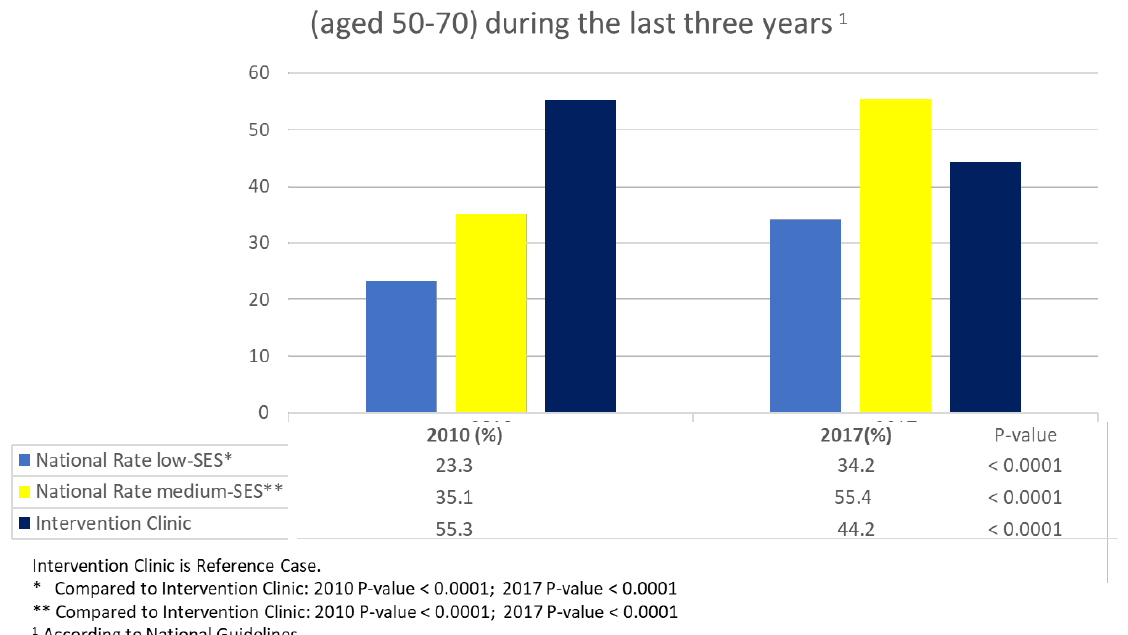
Figure 2. National and Intervention Clinic Data for Mammography Utilization in 2010 and